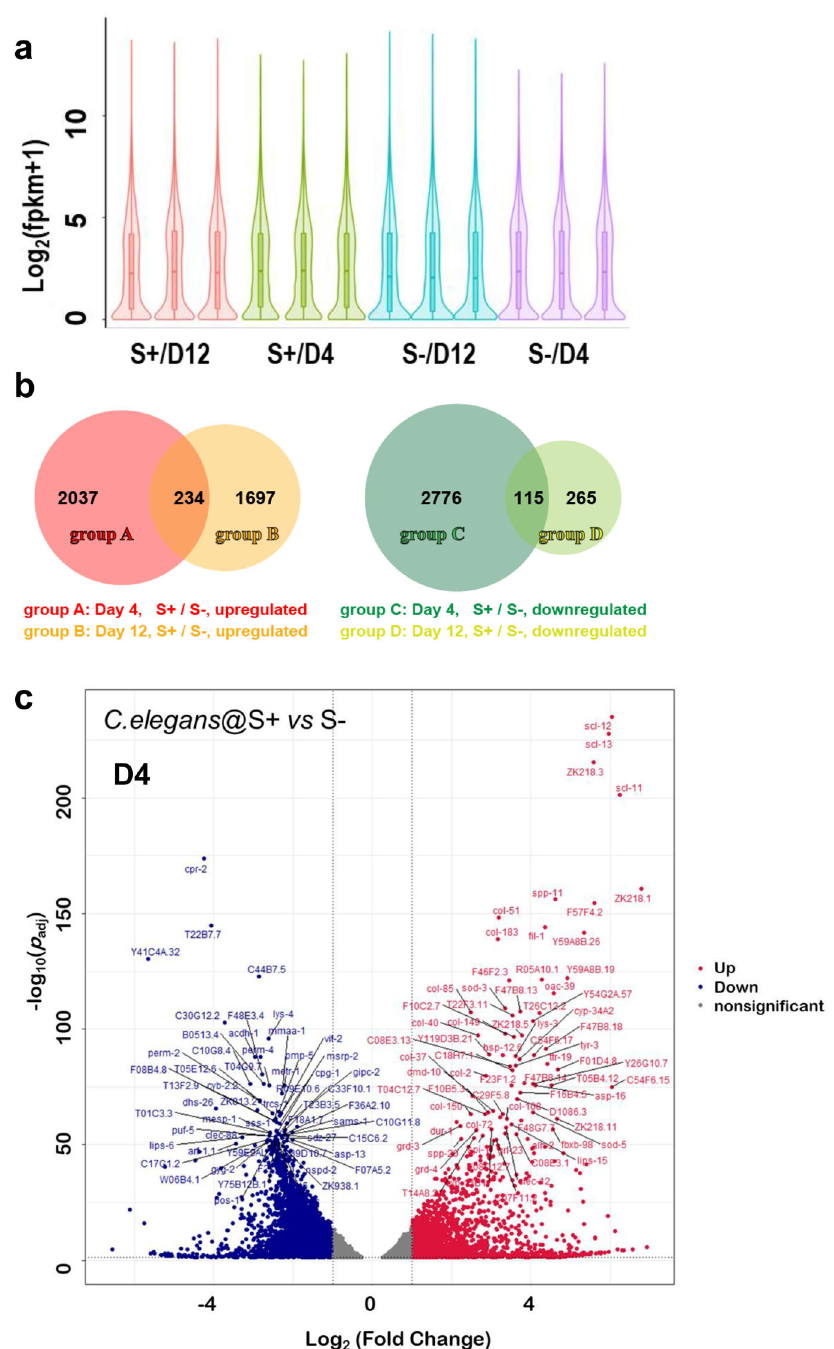
Fig. 4 Overview of RNA-seq results. a The FPKM distributions in the 12 samples (3 replicates for each group). b Venn diagram of differential gene expression between the two groups of Caenorhabditis elegans in RNA-seq. c Volcano plot of transcriptome differences between C. elegans S + and S-, in the D4